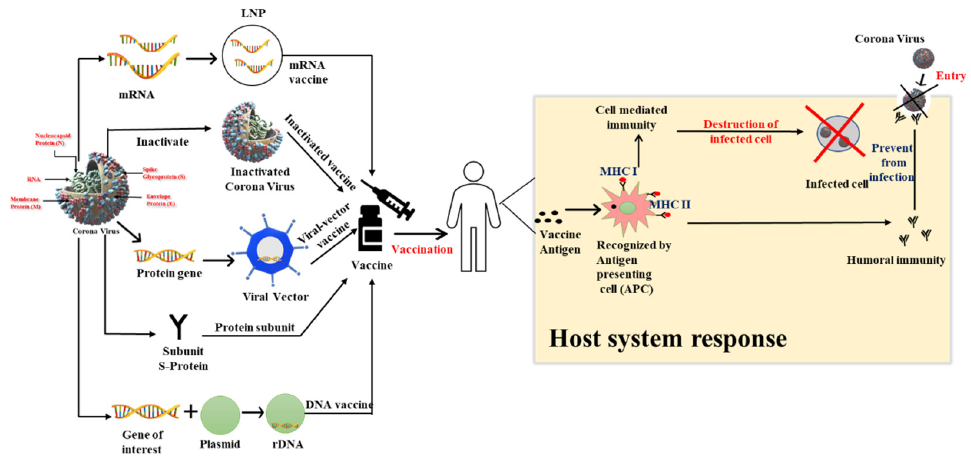
Figure 3. Vaccine strategies and immune response.